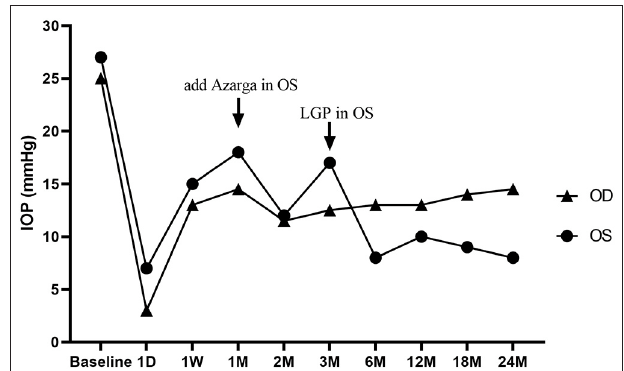
FIGURE 3 | Changes of intraocular pressure (IOP) in both eyes during the 2-year follow-up period. A CO 2 Laser-assisted Sclerectomy Surgery (CLASS) was first performed in the left eye (OS) and then a Microcatheter-assisted Trabeculotomy (MAT) surgery was performed in the right eye (OD). A fixed combination anti-glaucoma medicine (Azarga ® ) was added at 1-month post-CLASS, and a YAG laser goniopuncture (LGP) was performed to enhance the IOP-lowing effect at 3-month after CLASS. D: day; W: week; M: